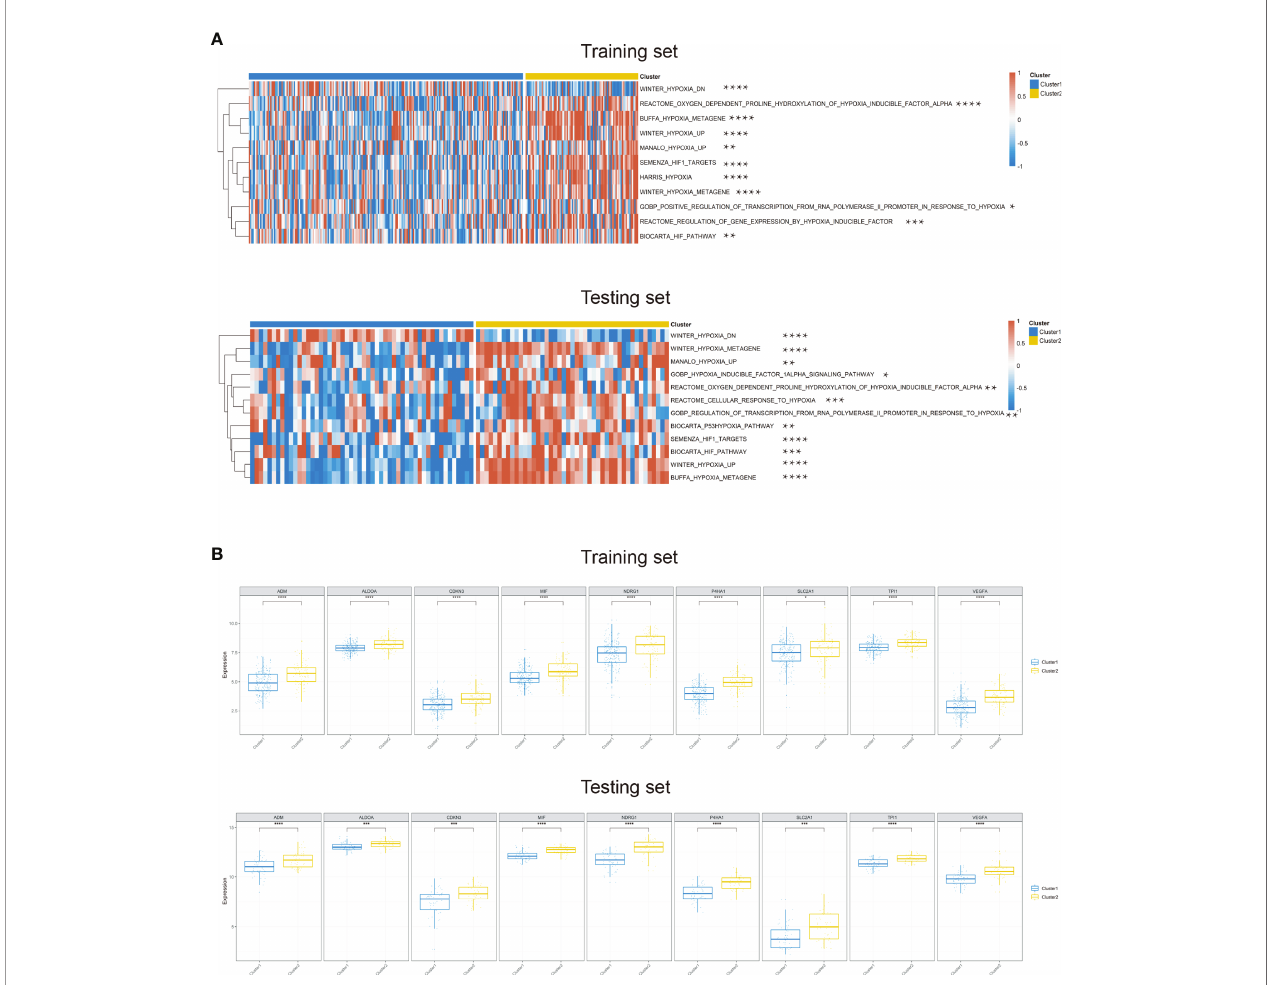
FIGURE 2 | Differential hypoxia conditions across two identi fi ed clusters. (A) Heatmap of the signi fi cant differential hypoxia pathways of two OSCC clusters based on ssGSEA in the training set and testing set. (B) The expression of nine hypoxia key genes upregulated in cluster 2 in the training and testing sets (* P < 0.05, ** P < 0.01, *** P < 0.001, **** P <